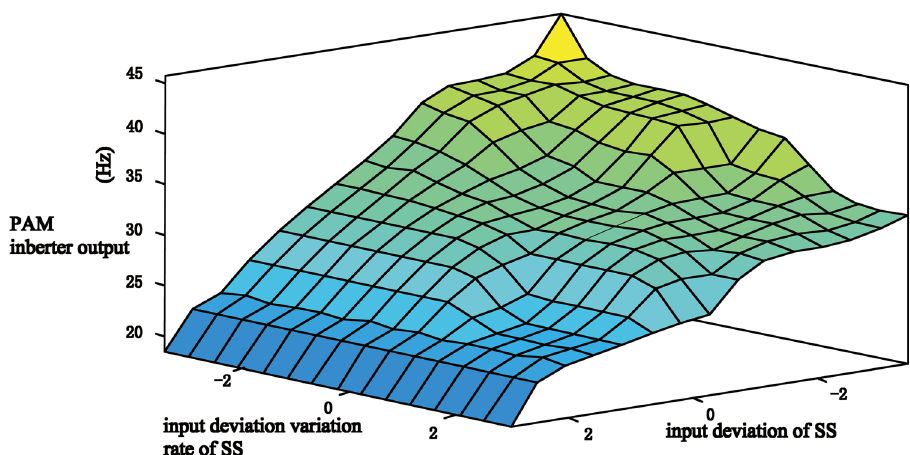
Fig. 7 Output characteristic surface of the PAM